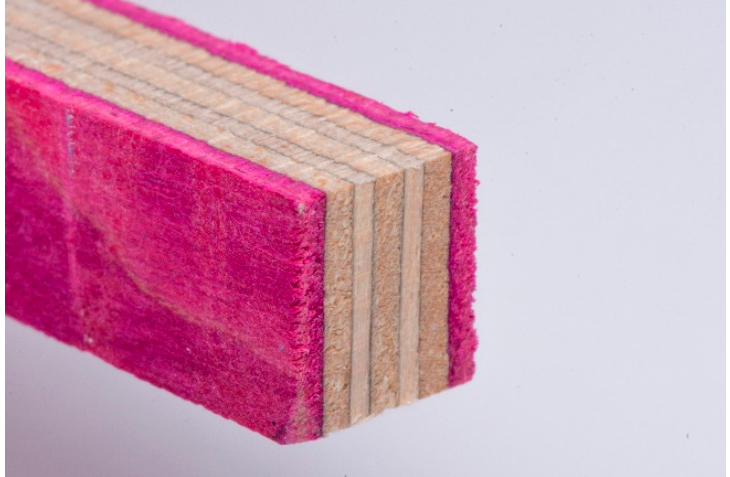
Figure 8. Edge Wise Strip Orientation.